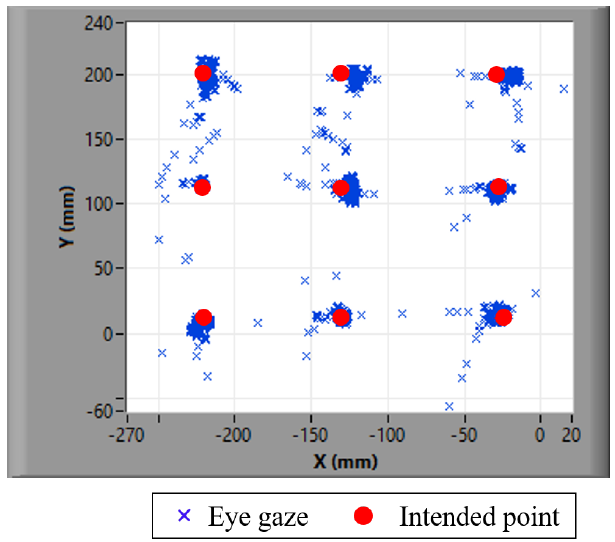
Figure 27. Trajectories of eye gaze at the intended points of nine poles.